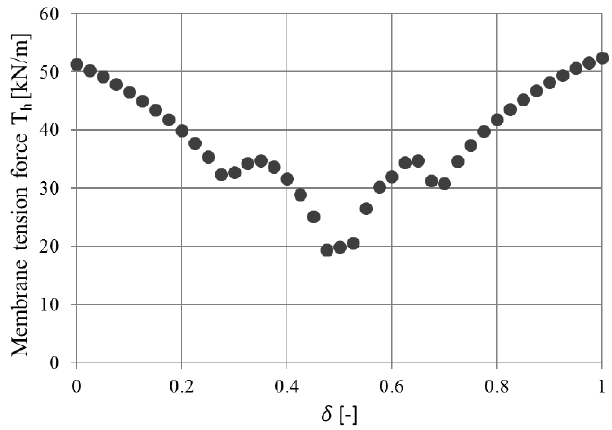
δ (3R, 9 δ (3R, 9 days).